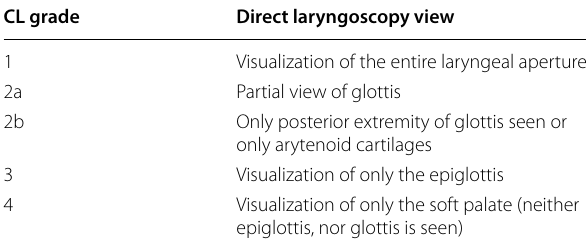
Table 2 Modified Cormack-Lehane Grade classification